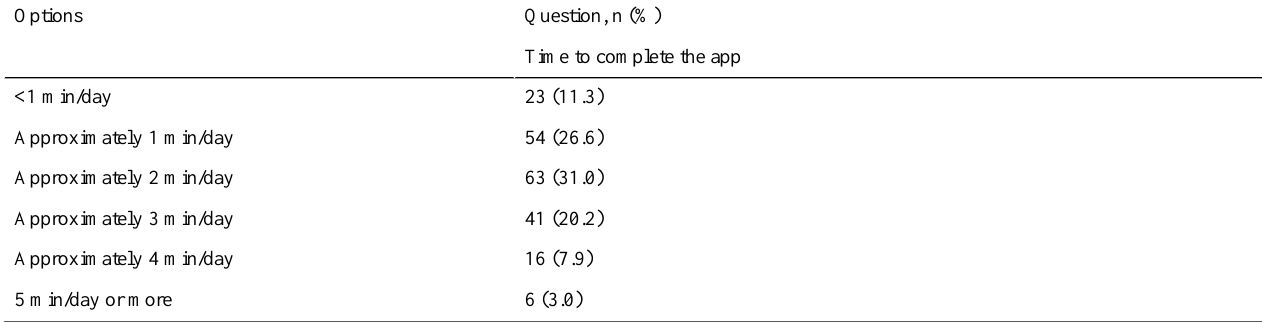
Table 15. Responses of the study participants to the usability rating questionnaire for the electronic 12-hour dietary recall app (part